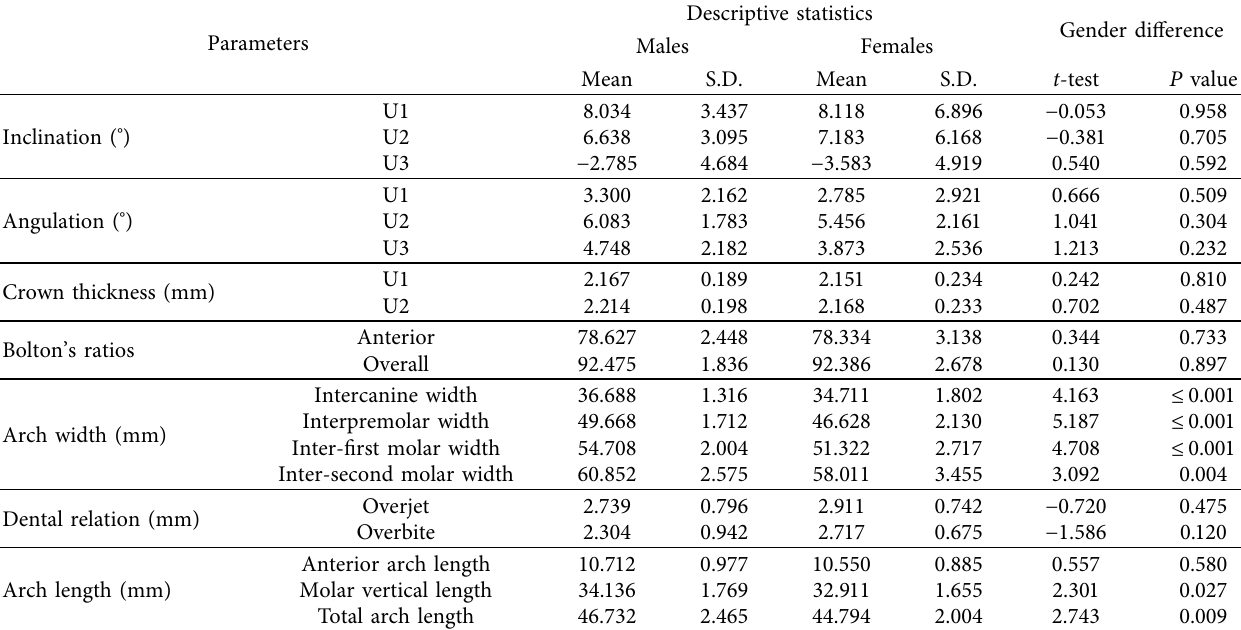
Table 1: Descriptive statistics and gender differences for all measured